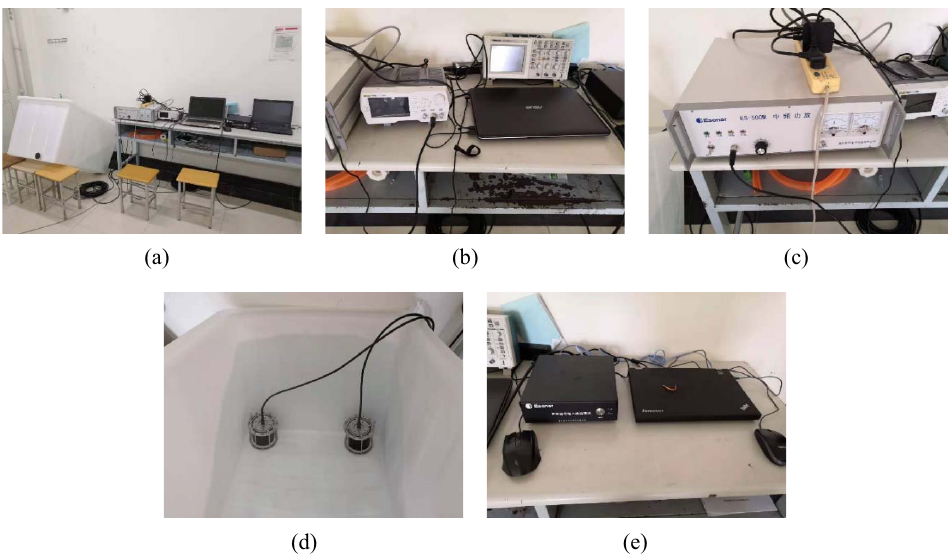
Figure 13. Experimental instruments in the Yellow Sea. ( a ) The whole system; ( b ) transmitter; ( c ) power amplifier; ( d ) the transducer and the hydrophone; ( e )